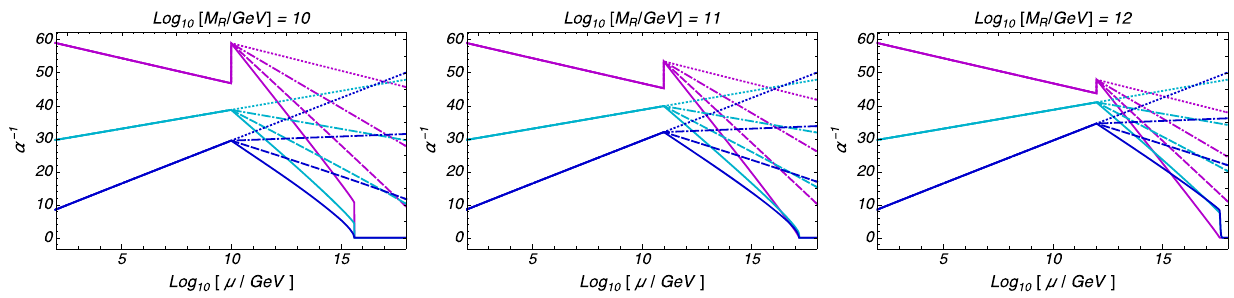
Fig. 1 The RG flow of the gauge couplings for M R = 10 10 GeV, M R = 10 11 GeV and M R = 10 12 GeV form left to right. Below the LR symmetry breaking scale M R , the purple, light-blue, and blue lines refer to gauge couplings of U ( 1 ) Y , SU ( 2 ) L , and SU ( 3 ) C gauge groups,